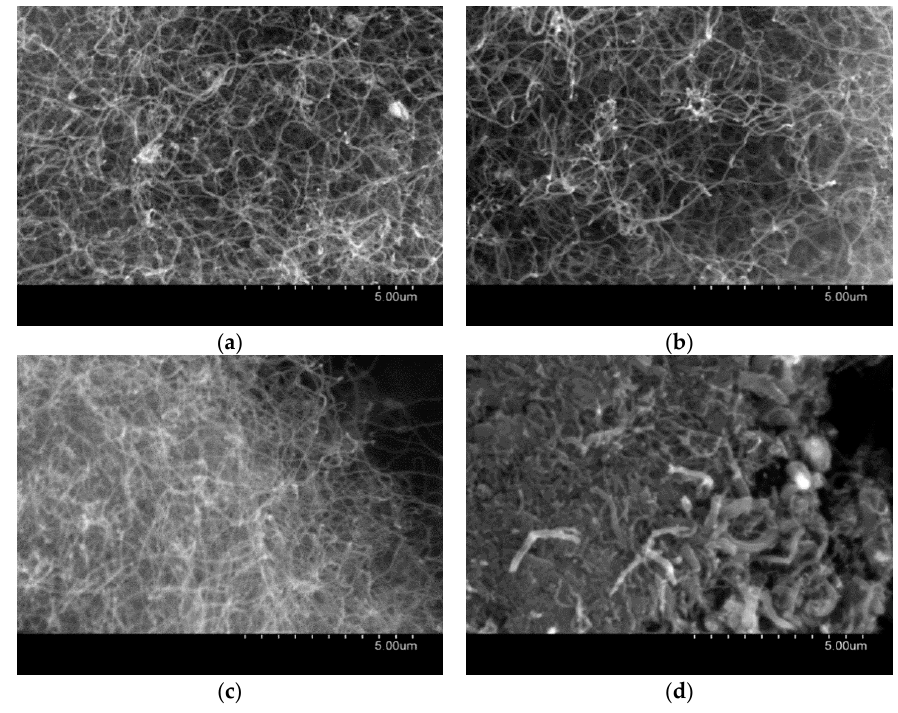
Figure 7. SEM micrographs of the carbon nanofilaments obtained on ( a ) Ni/Al; ( b ) Ni–Co/Al; ( c ) Ni–Cu/Al; and ( d ) Ni–Fe/Al catalysts. CDM was carried out in a quartz FBR for 120 min with an operating temperature of 650 °C.